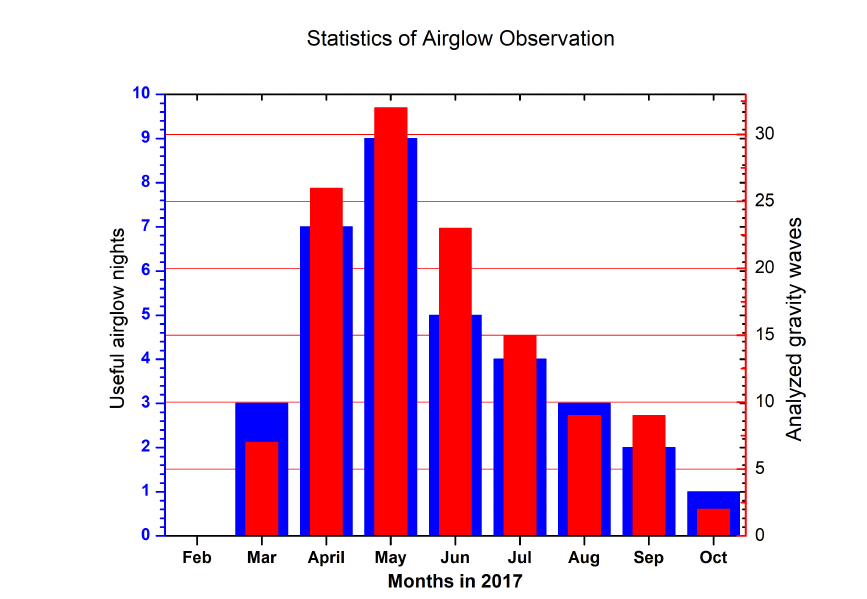
Figure 5. Statistics for the all-sky airglow observation at EACF in 2017. Number of nights with observed gravity waves (blue) and number of analyzed waves (red) per month.